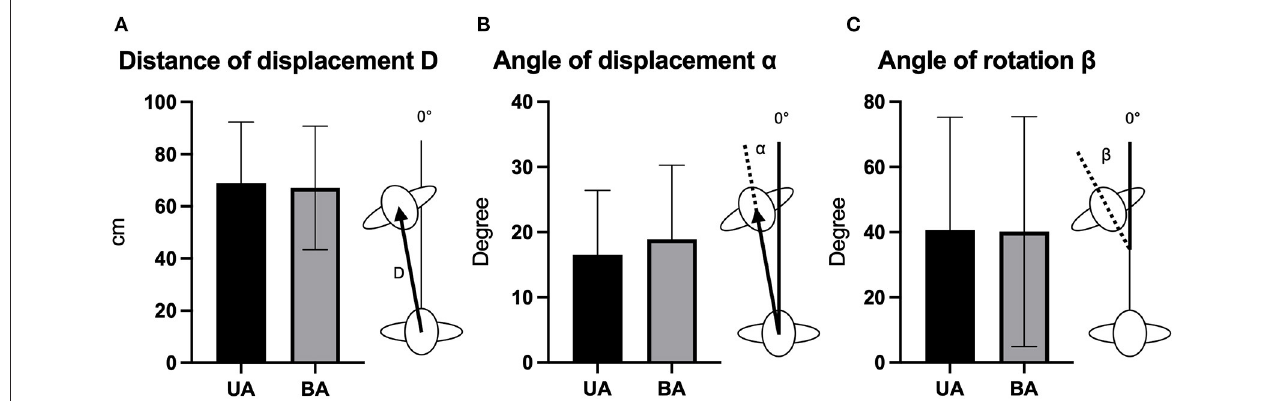
FIGURE 1 | Comparative illustration and schematic depiction of the distance of displacement D (A) , the angle of displacement α (B) , and the angle of rotation β (C) for the conditions best aided (BA) and unaided (UA) (mean and standard deviation). cm, centimeter.